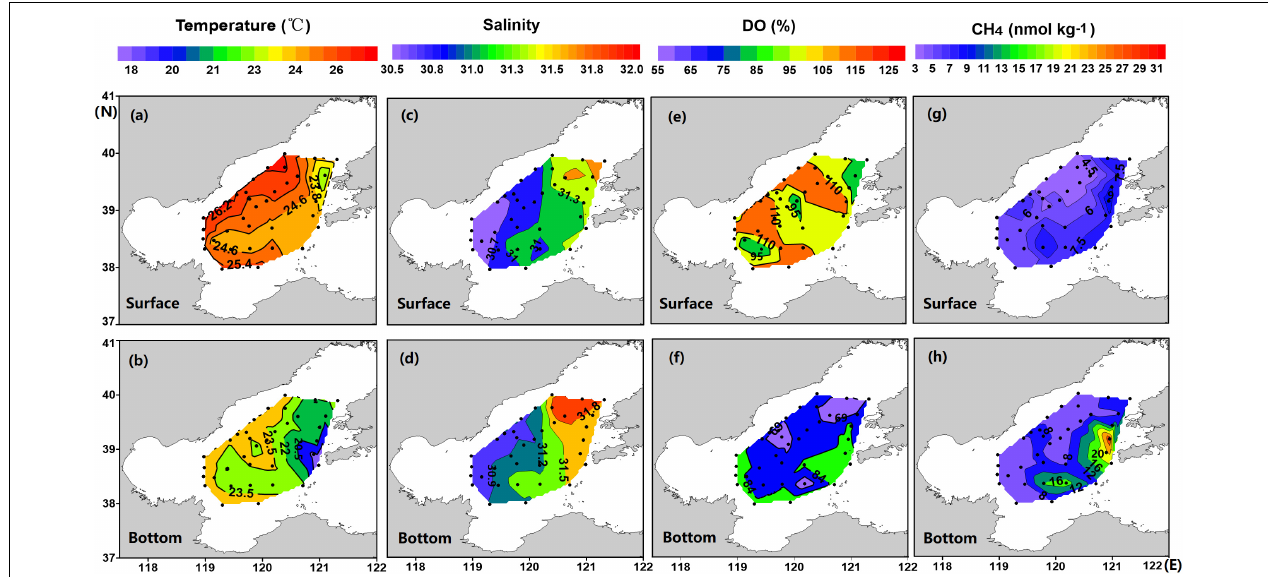
FIGURE 2 | Sea surface and bottom-water distributions of temperature (a,b) , salinity (c,d) , DO saturation (e,f) , and [CH 4 ] (g,h) in the central Bohai Sea in summer